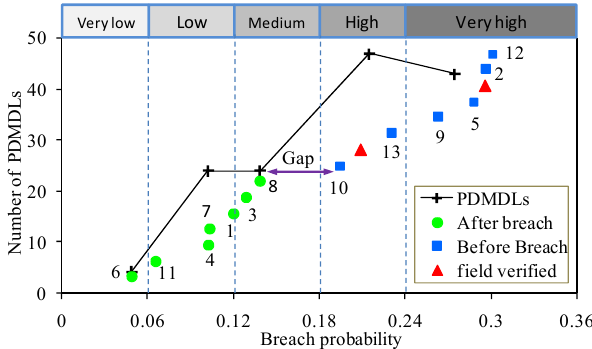
Fig. 4. Distribution of breach probability for PDMDLs and 15 ex- ample moraine-dammed lakes (numbers are the identifying num- bers of the MDLOF lakes in Fig. 1a). The scale with intervals of 0.06 defines the probability rates (top of graph). The evident gap marked by the arrows between after-breach (very low to medium breach probability) and before-breach (high to very high breach probability) lakes shows the reliability of the event-tree